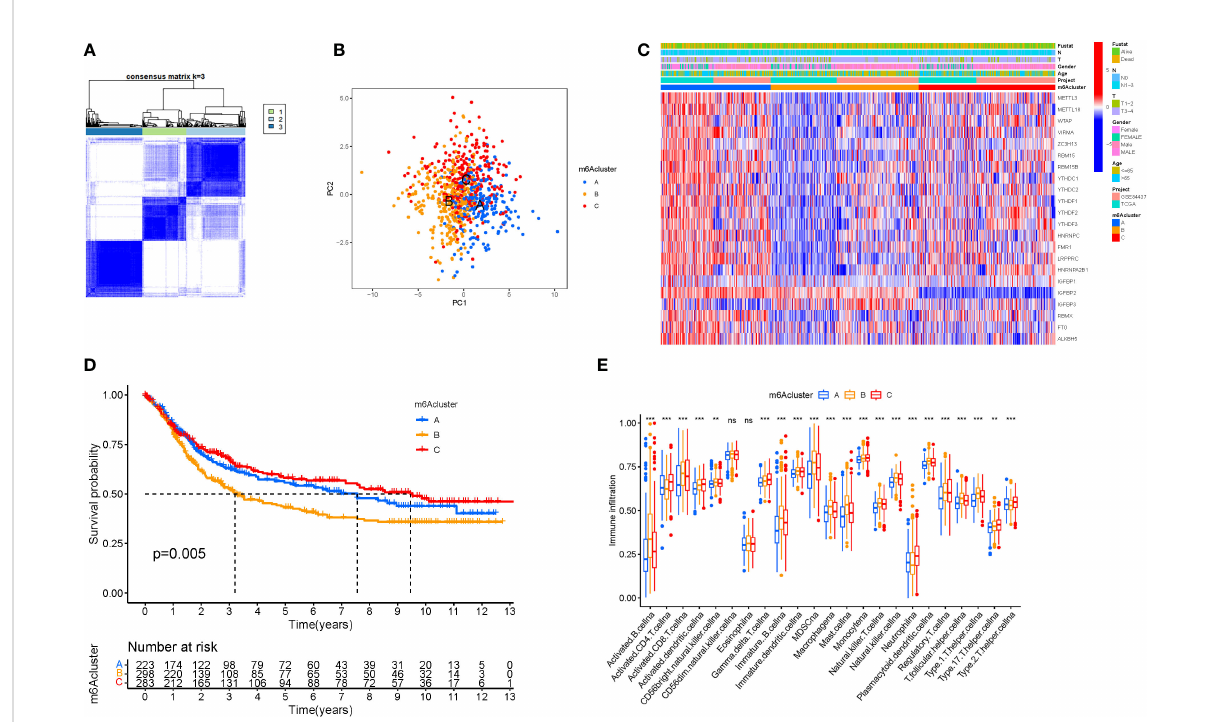
FIGURE 3 Tumor classi fi cation and Immune cells. (A) The consensus (When k was 3, intraorganizational ties were the greatest and intergenerational relationships were the lowest). (B) PCA (The patients were separated into three groups based on their level of risk). (C) Heatmap. (D) Kaplan-